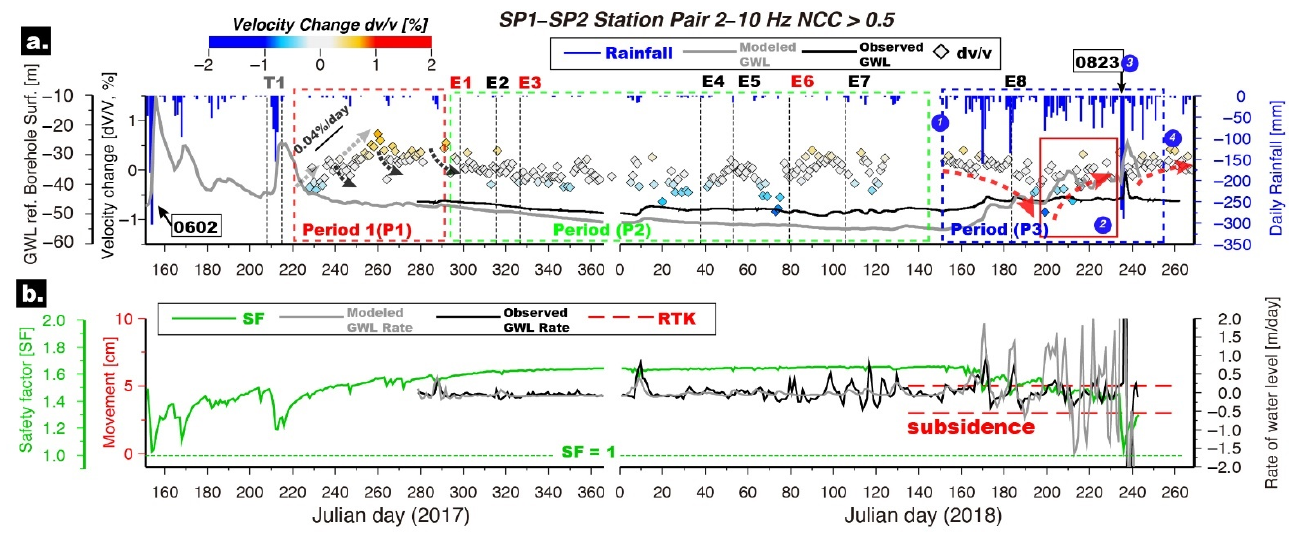
Figure 3. Seismicity, geodetic measurement, time series of dv / v , groundwater level, rainfall, and the safety factor: ( a ) Diamonds with colored scales (red: increase; blue: decrease) indicate the dv/v measurements related to a frequency range of 2–10 Hz. Nine earthquakes (Nos. E1–E8, seismic intensity III: black color; seismic intensity IV: red color) with seismic intensities larger than II occurred during the monitoring period. (The peak ground acceleration was higher than 8.0 Gal. T1 represents the time period during the Nesat and Haitang typhoons. Gray and black curves represent the modeled and observed groundwater levels (GWLs). The blue histogram indicates the daily precipitation. A cycle of reduction-and-recovery can be observed during periods 1 and 3 (P1 and P3), and frequent earthquakes occurred during period 2 (P2). The four stages of periods 1–4 are discussed in the section of 5.3. Relative Seismic Velocity Changes. The green square indicates the periods corresponding to the recovery process at the landslide site. ( b ) Horizontal red lines indicate the vertical subsidence of landslide area during intense precipitation. Gray and black curves indicate the modeled and observed GWL rate. The green line represents the long-term slope stability analysis results of the B3 potential sliding mass. The numbers 0602 and 0823 indicate the dates of two torrential rain events.